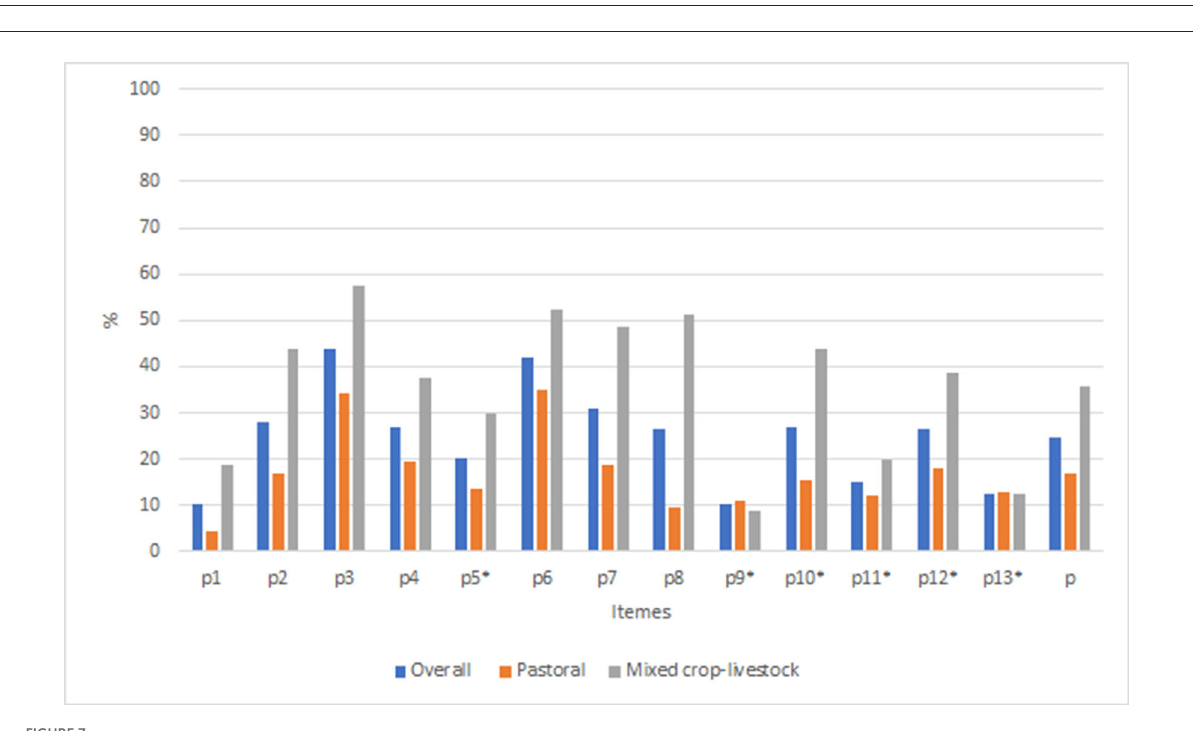
scale were relatively easy for the respondents with